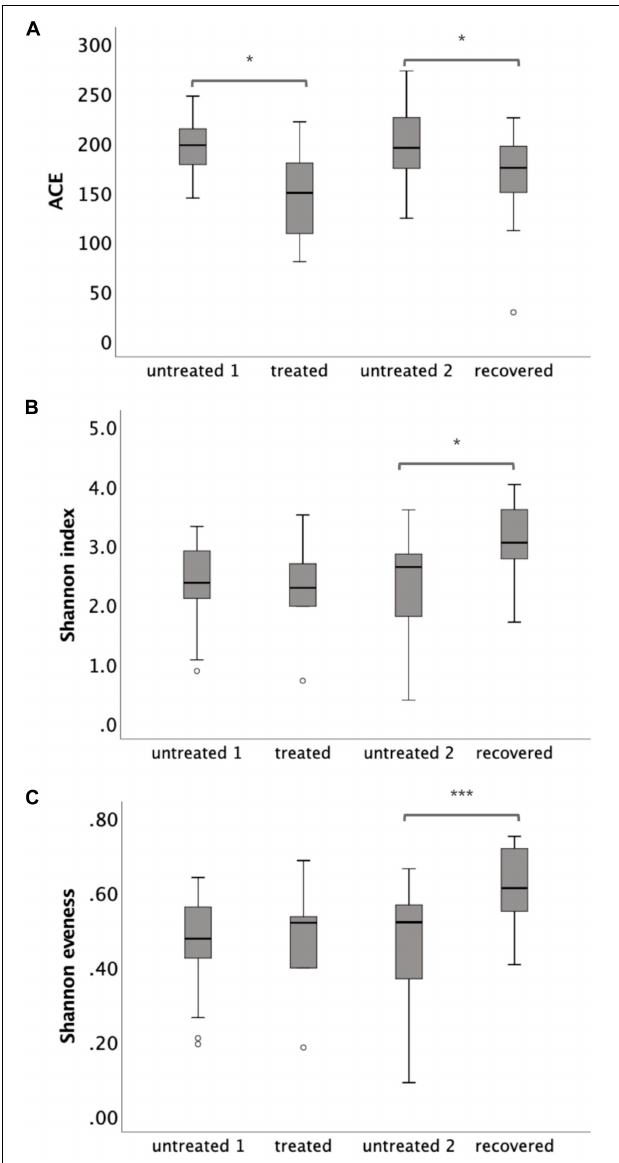
FIGURE 1 | The α -diversity of gut microbiota at the operational taxonomic unit (OTU) level, which was measured by (A) ACE, (B) Shannon index, and (C) Shannon evenness. Statistical significance was calculated between the multi-drug-resistant tuberculosis (MDR-TB) treated group and untreated group 1 and between the MDR-TB recovered group and untreated group 2 (Mann–Whitney U test). * p < 0.05, *** p < 0.001.